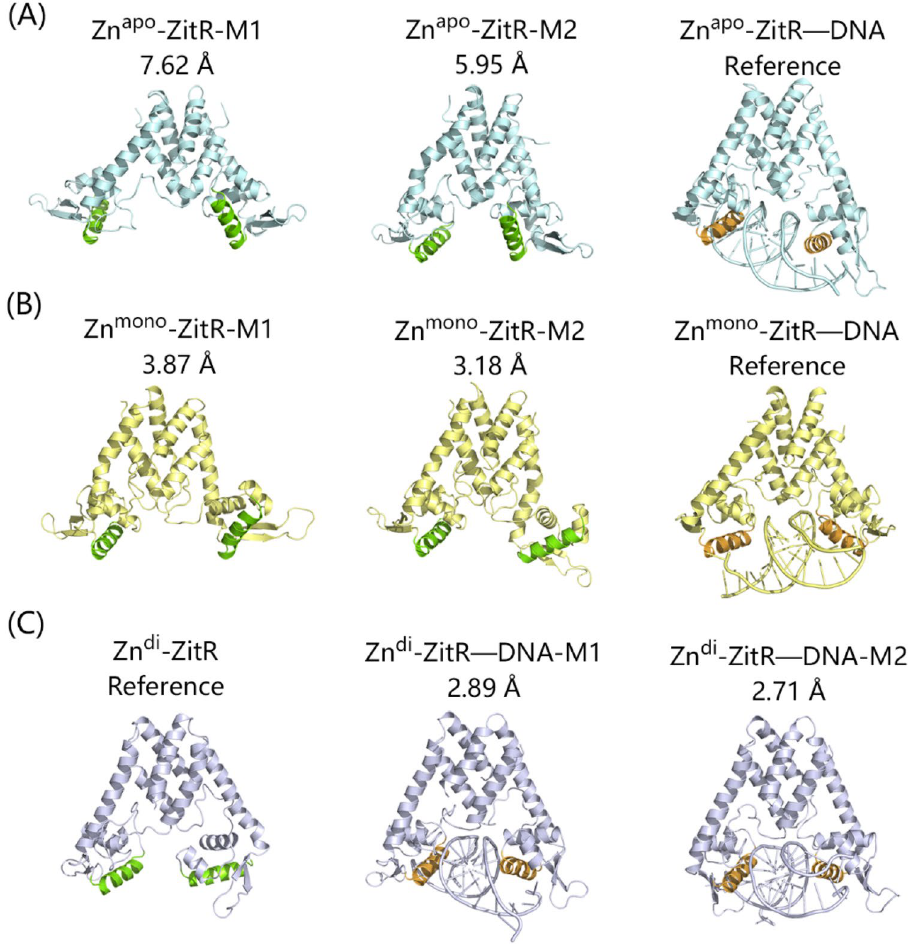
Figure 4. Structures of major conformations of Zn apo –ZitR ( A ), Zn mono –ZitR ( B ), and Zn di –ZitR ( C ). Chain A and B are located on the left and right sides, respectively. α4 and α4 ′ helices are colored as green cartoons without DNA binding and as orange cartoons when binding to DNA. Numbers represent the RMSD values when superimposed to the reference